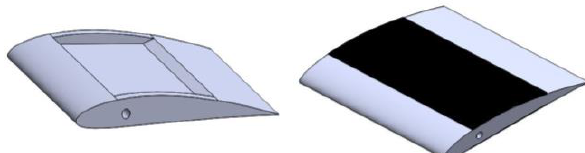
Fig. 1. The fabricating process of partial flexible airfoil [19] .